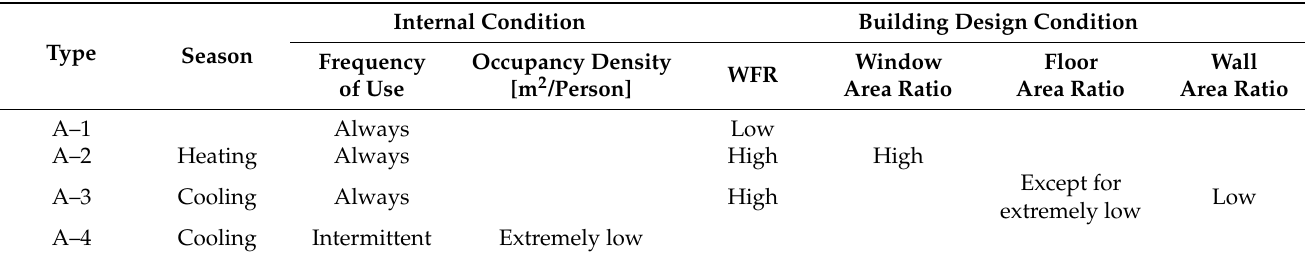
Table 6. Classification based on the internal and building design